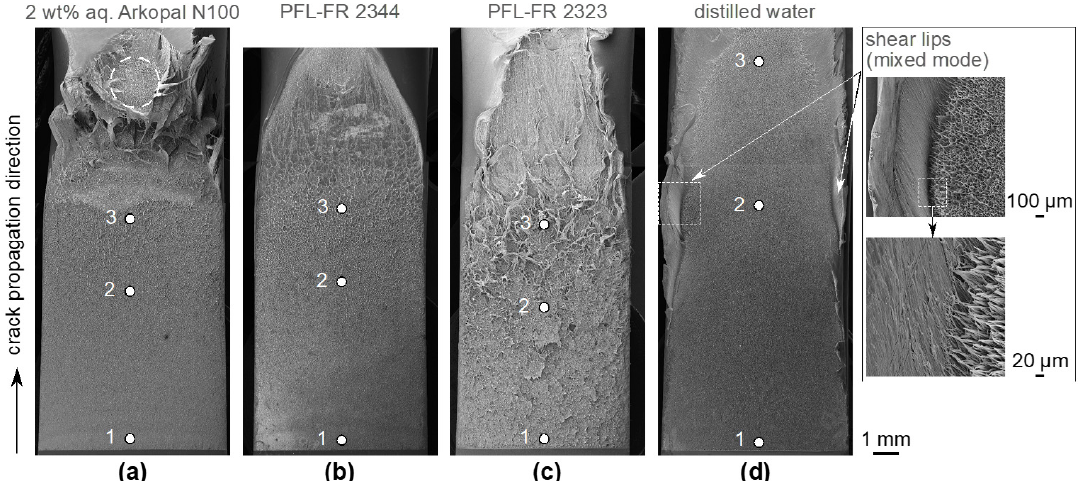
Figure 9. SEM images of fracture surfaces depending on the environmental medium ( a – d ) from the notch (bottom) to the transition from ESC to macroscopic ductile failure arresting crack propagation (top). Points 1, 2, and 3 indicate locations of detailed images in Figure 10. Formation of shear lips on the edge of the outer fracture surface along the crack propagation direction of the CT specimen when immersed in distilled water.